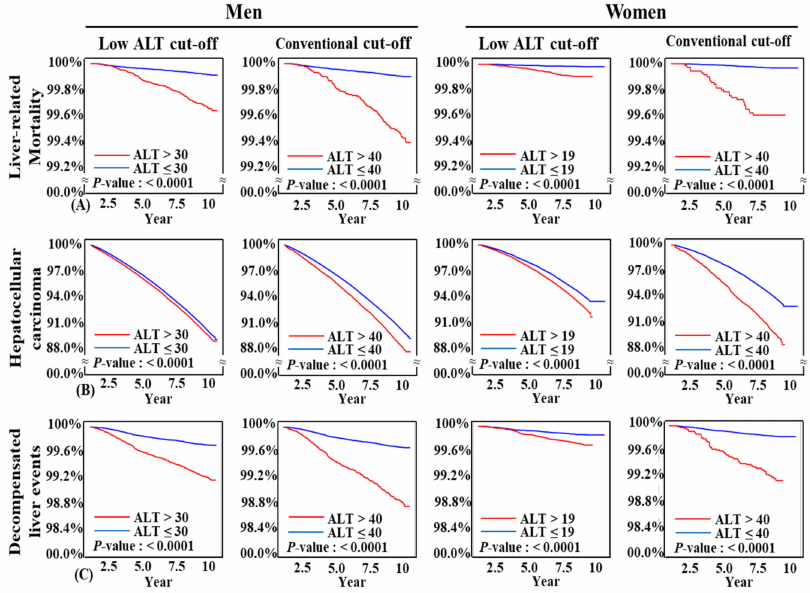
Figure 3. Kaplan-Meier curves for development of liver outcomes according to alanine aminotransferase levels: ( A ) Liver-related mortality; ( B ) hepatocellular carcinoma; and ( C ) decompensated liver